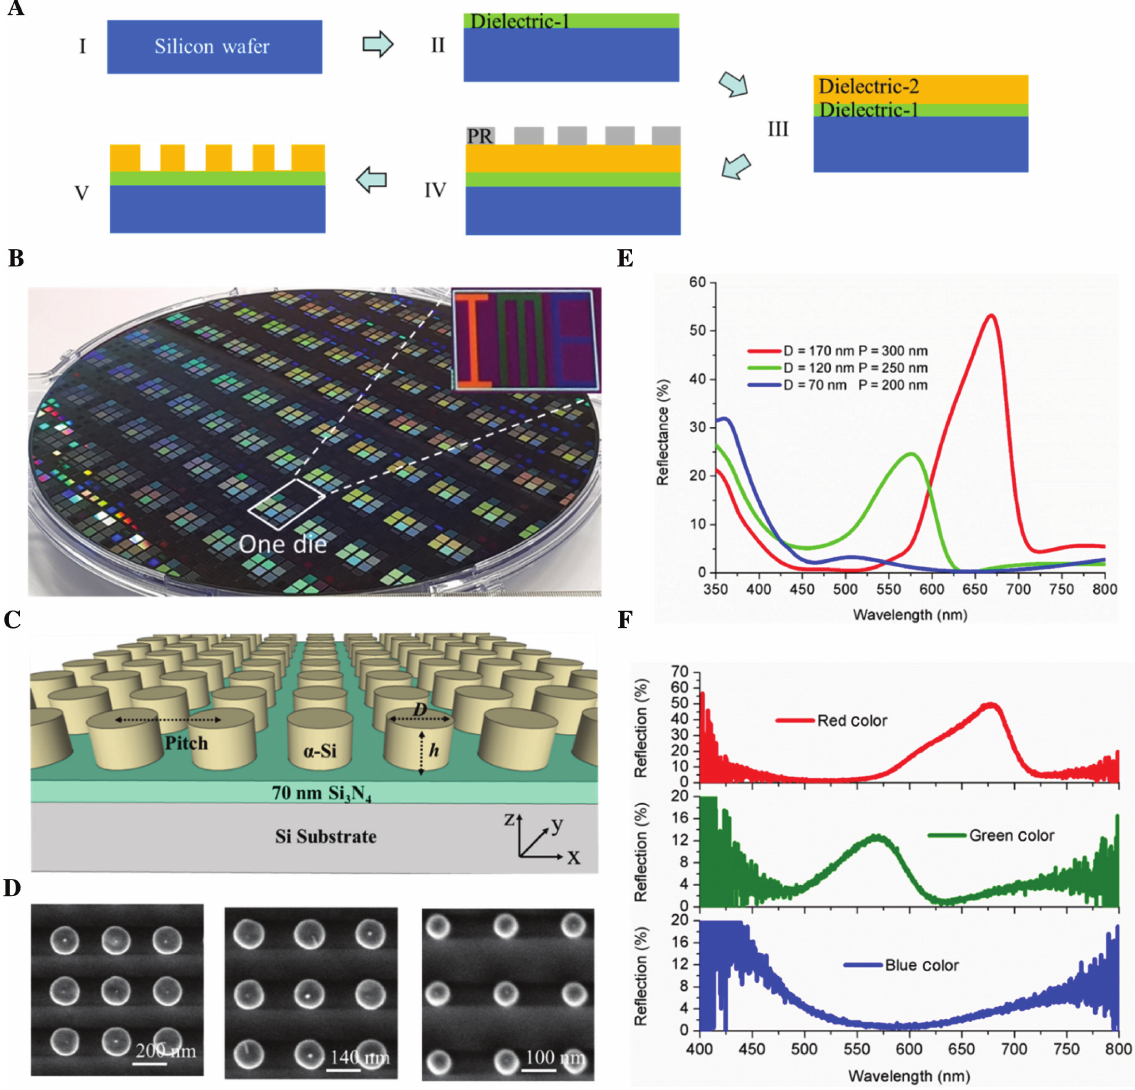
Figure 5: Metasurface-based devices demonstrated using an immersion scanner on 12-inch Si wafer with a dielectric layer on top. (A) Fabrication process flow. (B) Fabricated 12-inch Si wafer, with inset showing the color filtering from the metasurface layer in the visible wavelength range. (C) Schematic of the color display metasurface. (D) Top-view SEM images of the nanopillars patterned with pitch and diameter variations. (E) Design of the color filter, showing the reflection spectra of the nanopillar arrays with diameters of 170, 120,